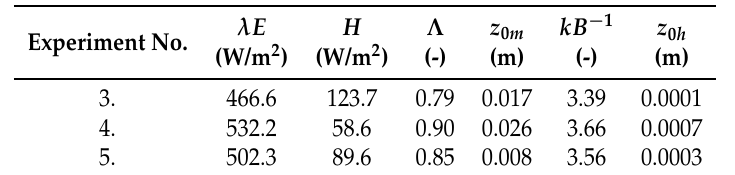
Table 5. Results of simulated heat fluxes densities and roughness length at the EC footprint scale after kB − 1